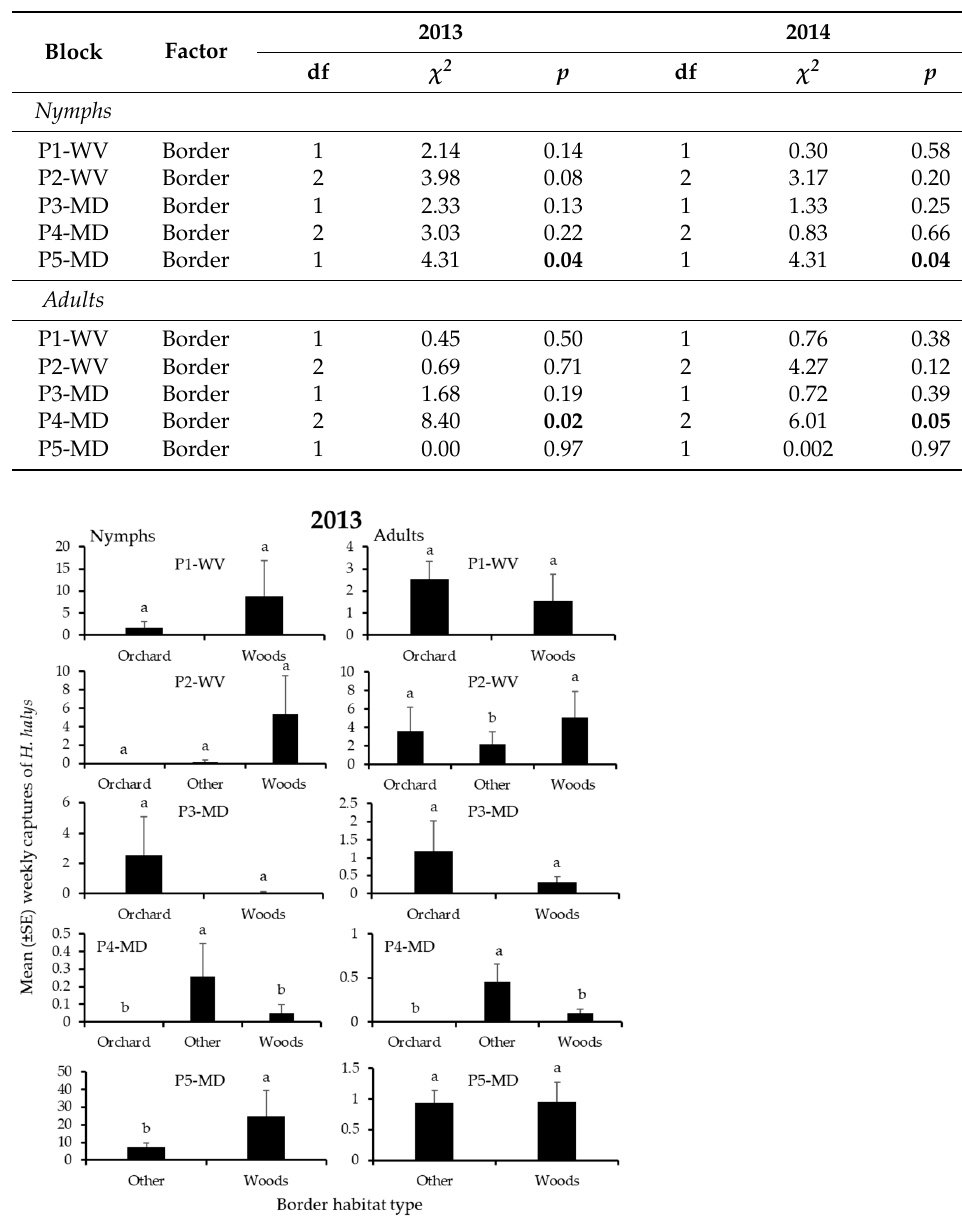
Figure 7. Mean ( ± SE) weekly trap captures of H. halys nymphs (left) and adults (right) in pheromone-baited traps on the perimeter of 5 peach orchard blocks in the Mid-Atlantic, USA, from 17 April to 12 September 2013. Bars with shared letters are not significantly different (Tukey HSD, α = 0.05).